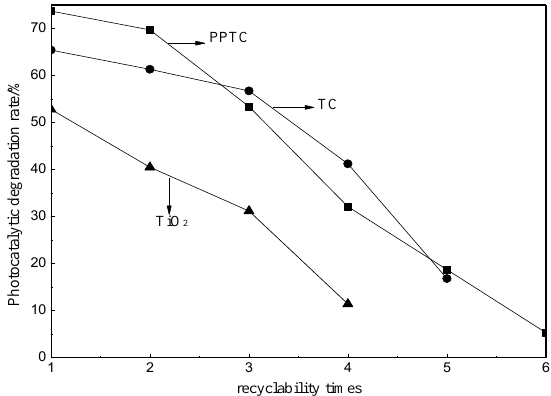
Figure 8. Photocatalytic degradation rate of DMF as a function of recycling number of TiO 2 , TC, and PPTC. Table 2. Degradation rate of DMF catalyzed by photocatalysts without illumination and under irradiation of simulated sunlight (Xe lamp) or real